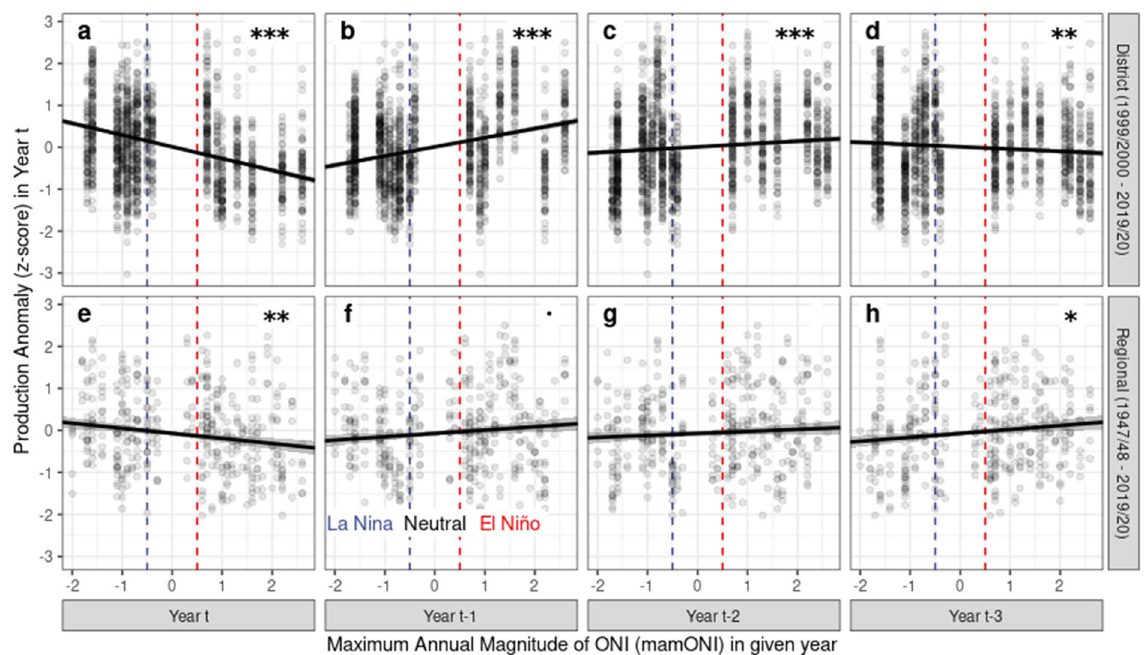
Figure 2. The instantaneous and delayed responses of cocoa production to ENSO phase, represented as mamONI. Vertical dashed lines delineate La Nina (mamONI ≤ − 0.5), Neutral (− 0.5 < mamONI < 0.5) and El Nino (mamONI ≥ 0.5) conditions. The relationships between Production Anomaly and mamONI through time are explored using a multiple regression for each dataset (panel rows: District dataset, 1999/2000–2019/2020, a – d ; Regional dataset, 1947/1948–2019/2020, e – h ) fitting the Production Anomaly in year t against mamONI in years t to t-3 (panel columns). Lines show the best linear fits and standard errors derived from each multiple regression. Significance stars denote the probability that a slope differs from zero (***p < 0.001, **p < 0.01, *p < 0.05, .: p < 0.1). Adjusted R squared for the District model was 0.20, for the Regional model